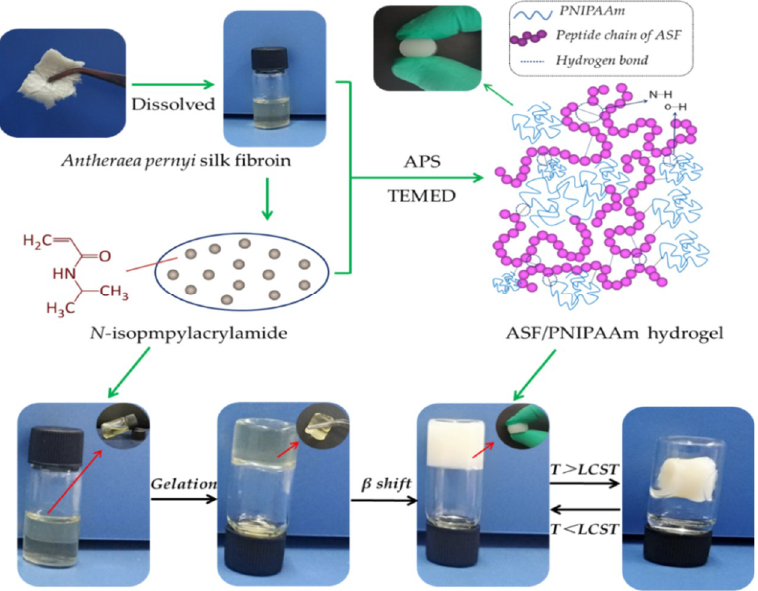
Figure 3. Preparation process of ASF/PNIPAAm composite hydrogel.